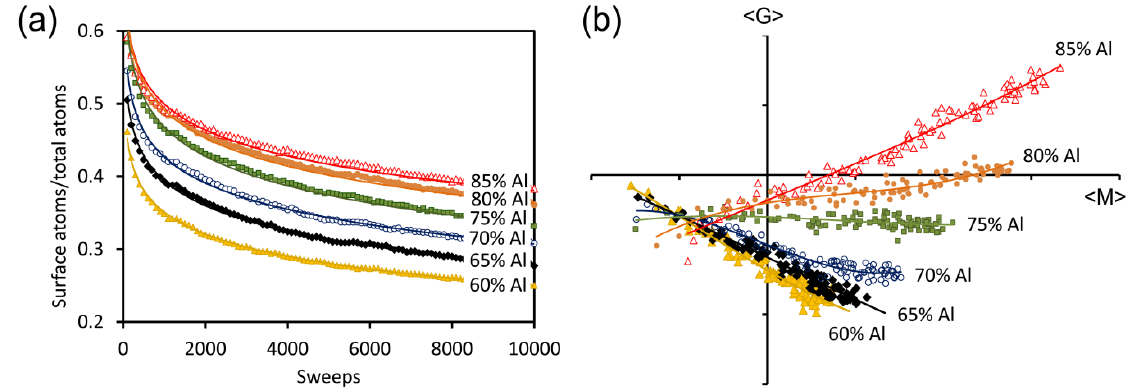
Figure 7. Changes in morphology in model sponges prepared from precursors containing between 60 and 85 at.% Al, as a function of Monte Carlo annealing time at T = 0. ( a ) ratio of surface atoms to total atoms; ( b ) average Gaussian curvature (<G>) plotted against average “mean curvature” (<M>) for the sponges shown in ( a ). Simulations start in the bottom left quadrant and sponge evolve towards more positive values of <M>.